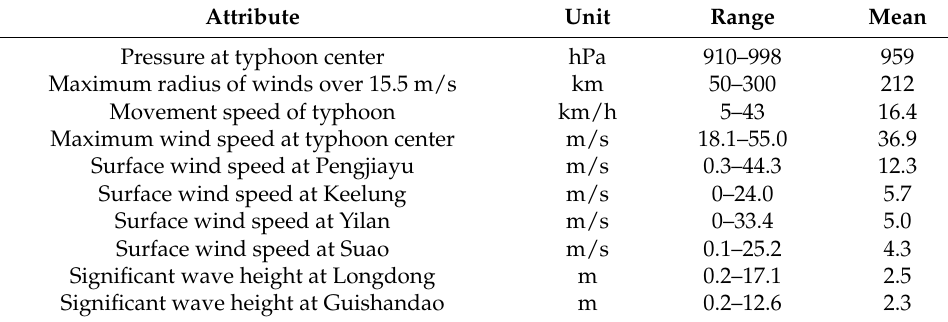
Table 2. Range and average values of the collected attributes.